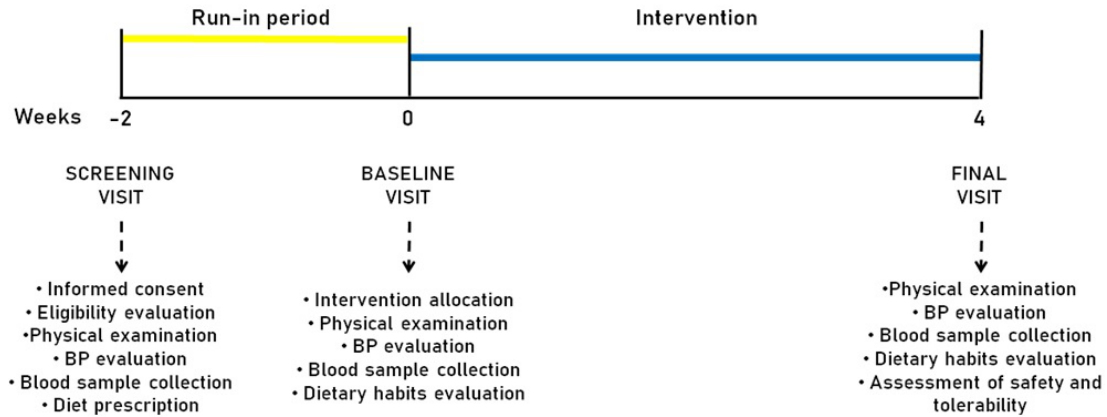
Figure 1. Timeline of the study. BP = Blood pressure.